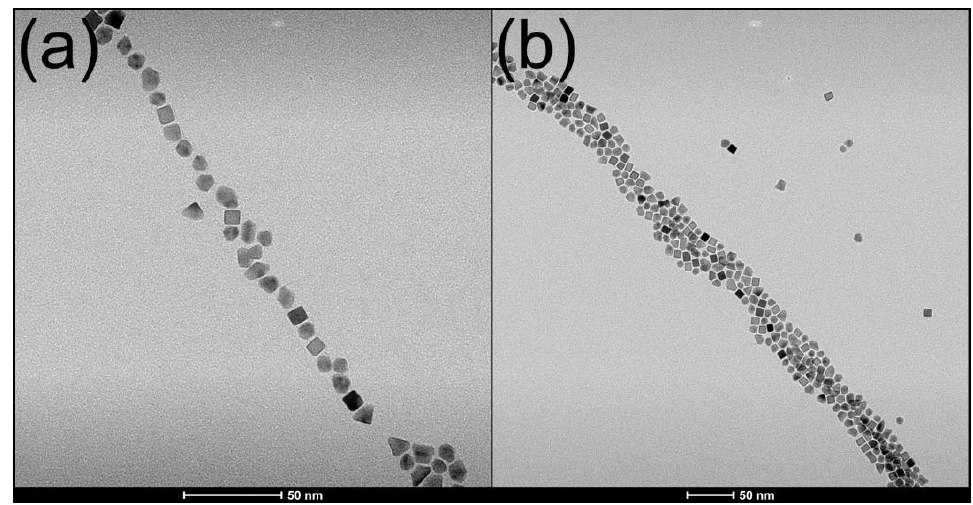
Figure 4. Transmission electron micrographs of dispersible platinum nanoparticles: ( a ) image of 8 nm cubic Pt NPs displaying {100}-faceted surfaces; ( b ) smaller, octahedral Pt NPs with dominant {111} facets can also be seen.